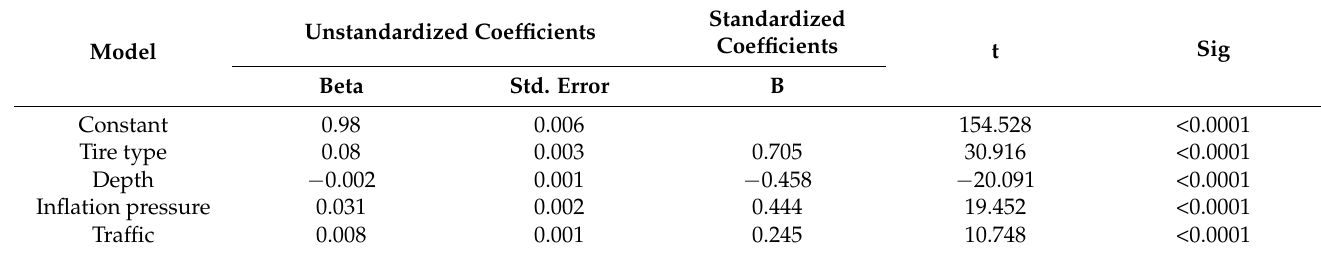
Table 5. Statistical characteristics of stepwise regression model for predicting soil bulk density.